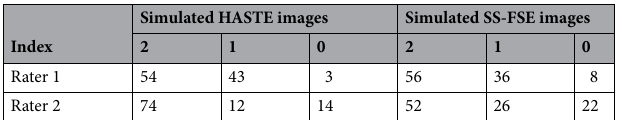
Table 5. Independent evaluation of the realism of the images generated using FaBiAN based on a quality index. Percentage of 2—highly realistic, 1—quite realistic, 0—non-realistic synthetic HASTE and SS-FSE images according to a neuroradiologist (Rater 1) and a pediatric (neuro)radiologist (Rater 2).